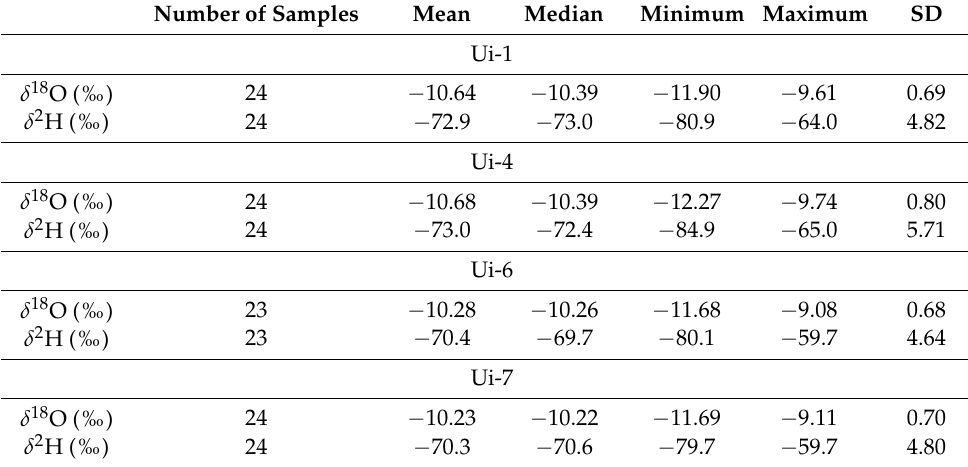
Table 2. Basic statistics of the isotopic composition of springs.